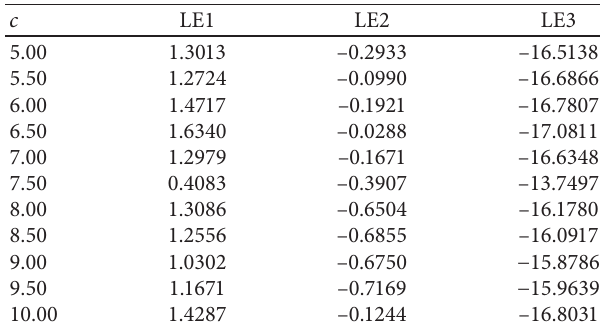
Figure 24: Dynamics of the fractional-order system in (13)–(15) with the order α � 0 . 92, in context of x and y Table 2: Lyapunov exponents.